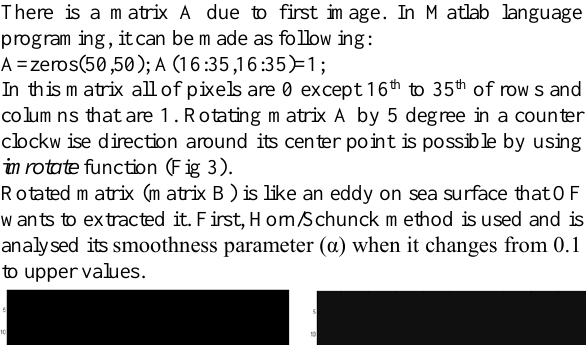
Figure 1. SST, Aqua. (a) 2 August 2010, 9:35. (b) 2 August 2010, 23:10